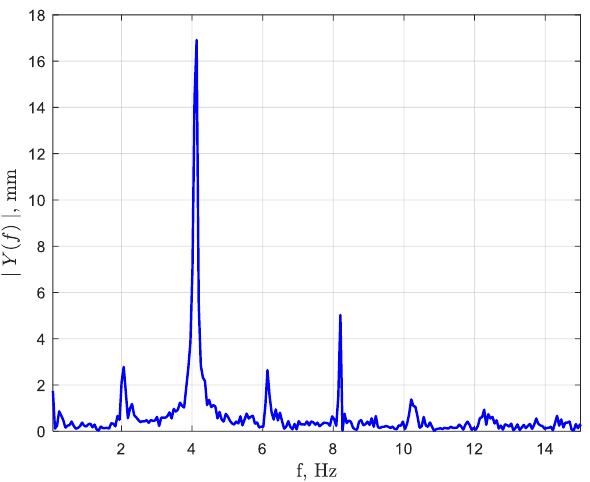
Figure 16. Fourier transform for rotating disk frequency of 4.6 Hz.